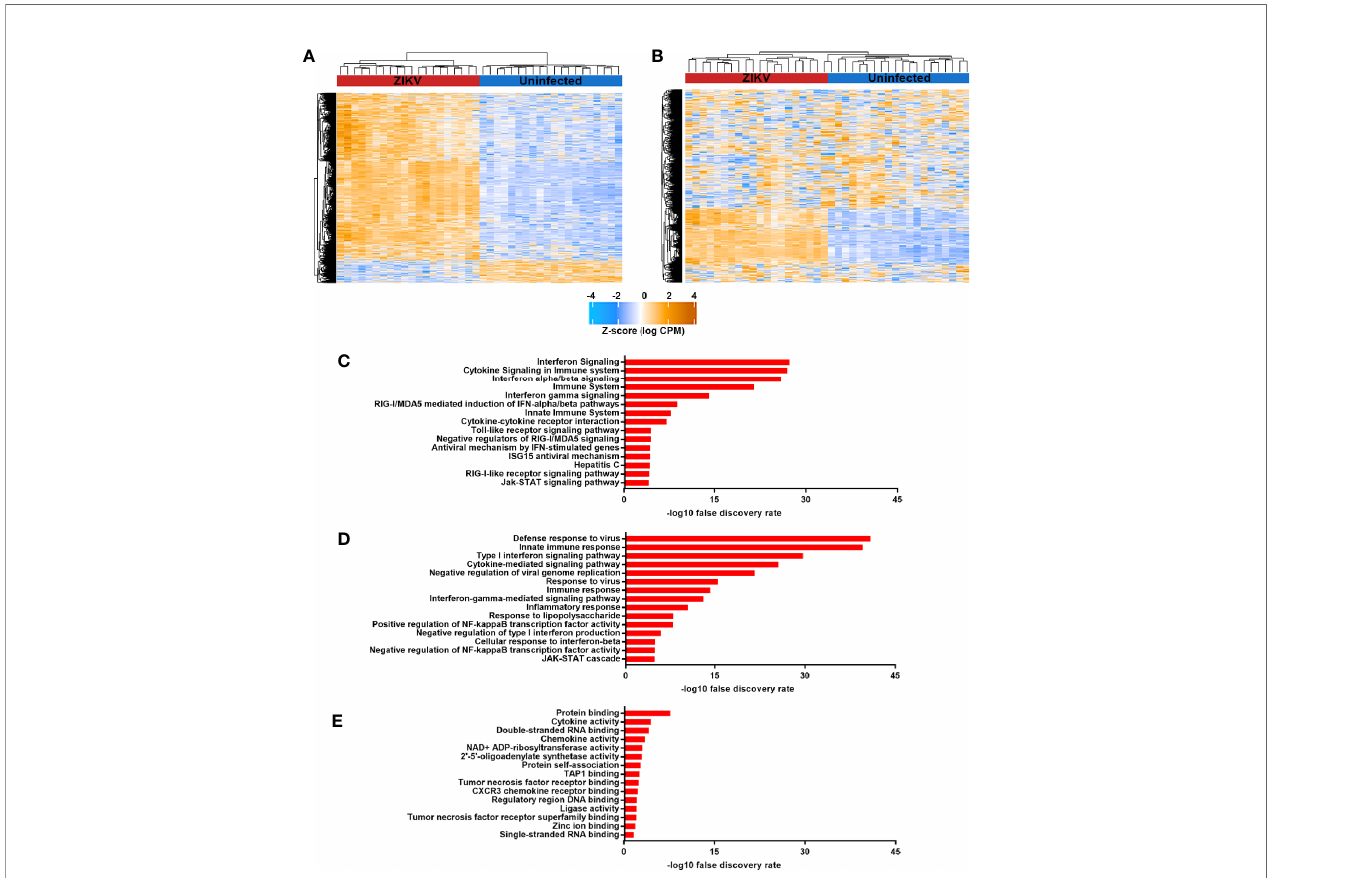
FIGURE 3 | (A) and (B) Heat maps indicating normalized counts per million from sequencing of total RNA from ZIKV-infected (red) and uninfected (blue) human iris pigment epithelial cells isolated from eyes of 20 individual donors. Z-score is shown for (A) all differentially expressed genes and (B) the 1,000 most variable genes. Color scale changes from orange to blue, with higher intensity orange representing higher counts for each transcript. (C – E) Graphs presenting the 15 most enriched categories – by (C) Reactome or KEGG pathways, (D) Gene Ontology biological processes and (E) Gene Ontology molecular functions – for genes that were upregulated in ZIKV-infected cells, as annotated in InnateDB (35).